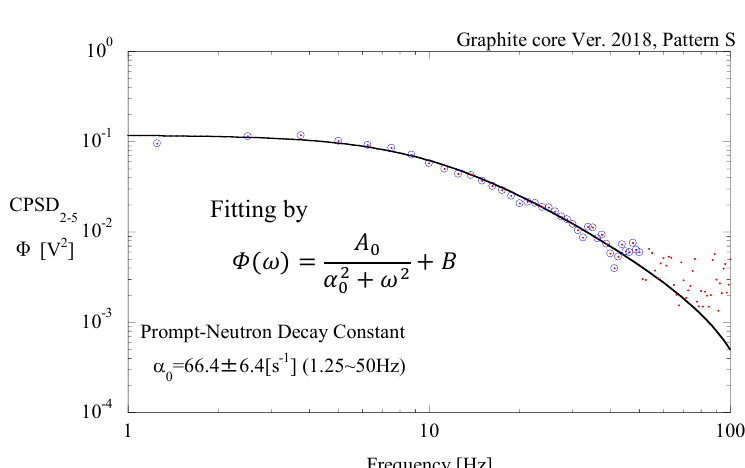
Figure 4. Cross - power spectral density between B2 and B5 in rod pattern S (critical state).